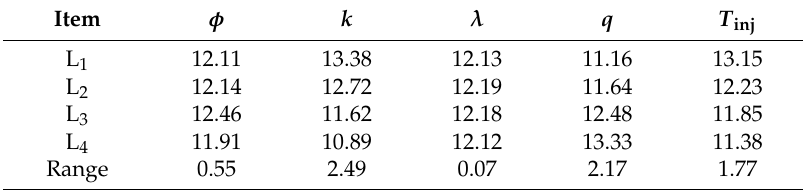
Table 7. Mean effects of different levels of conditions on the injection pressure at t = 20 years.